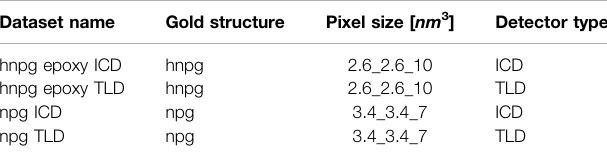
TABLE 5 | Speci fi cations of real FIB-SEM gold datasets used in this study. Note: All dataset discussed in the table have epoxy material as pore fi